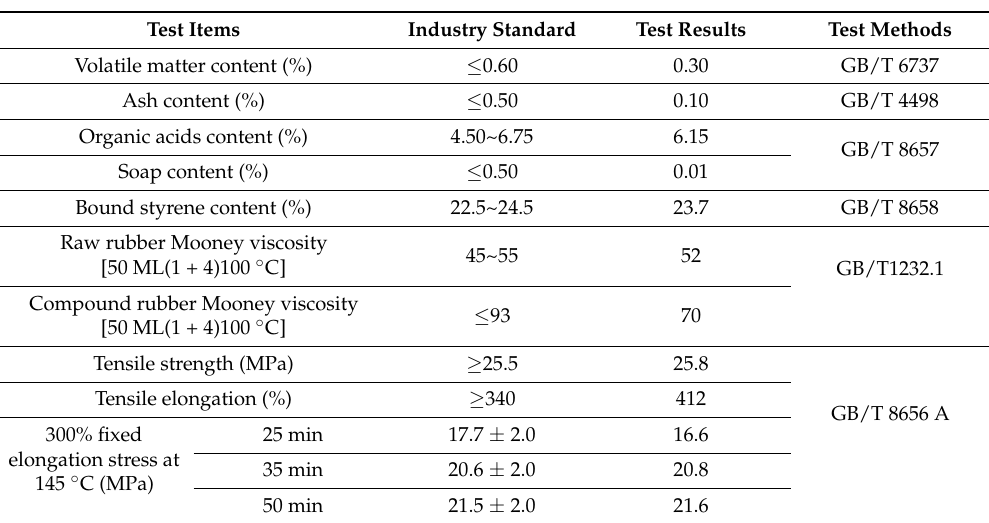
Table 3. Technical properties of SBR.